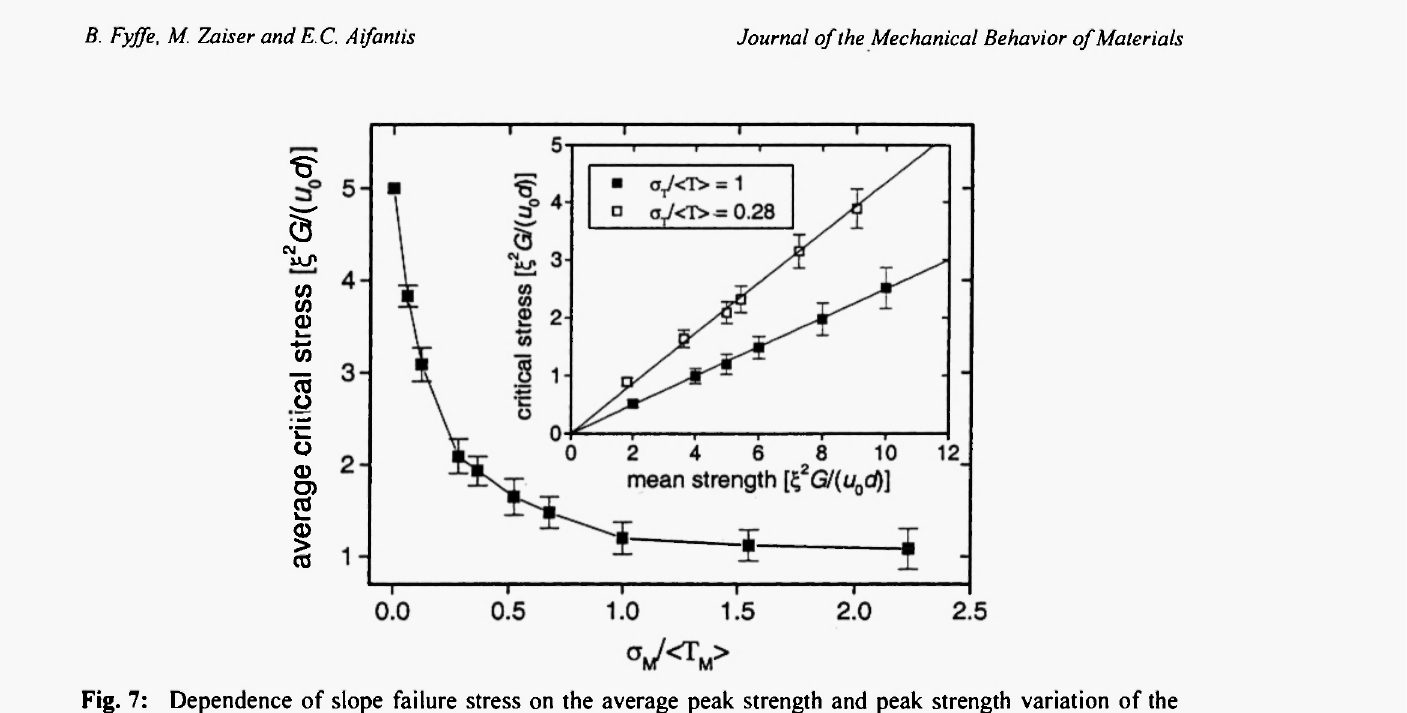
Dependence of slope failure stress on the average peak strength and peak strength variation of the weak layer. Main graph: critical stresses for average peak strength ( Tm)=5 and different values of the peak strength variation σ Μ / ( T m ). Insert: Dependence of failure stress on peak strength for two different values of the relative peak strength variation. Each data point represents an average over an ensemble of 100 systems; the error bars indicate the variance of the failure stress distributions.